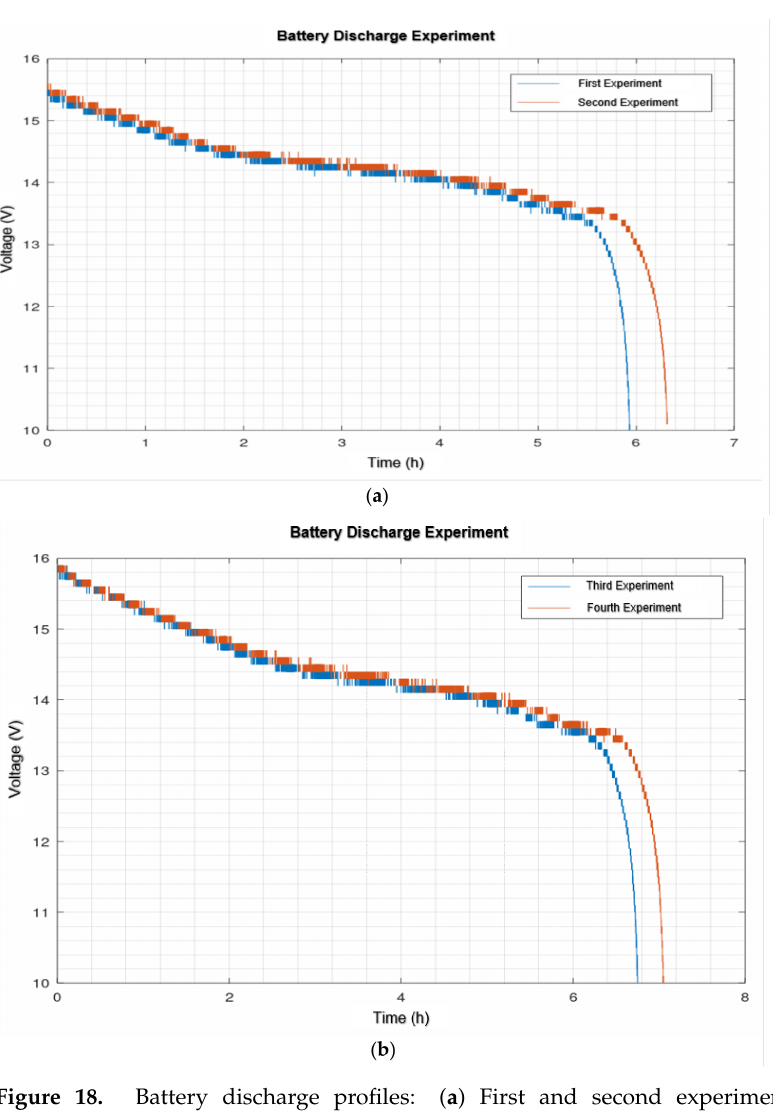
Figure 18. Battery discharge profiles: ( a ) First and second experiments, ( b ) Third and fourth experiments.